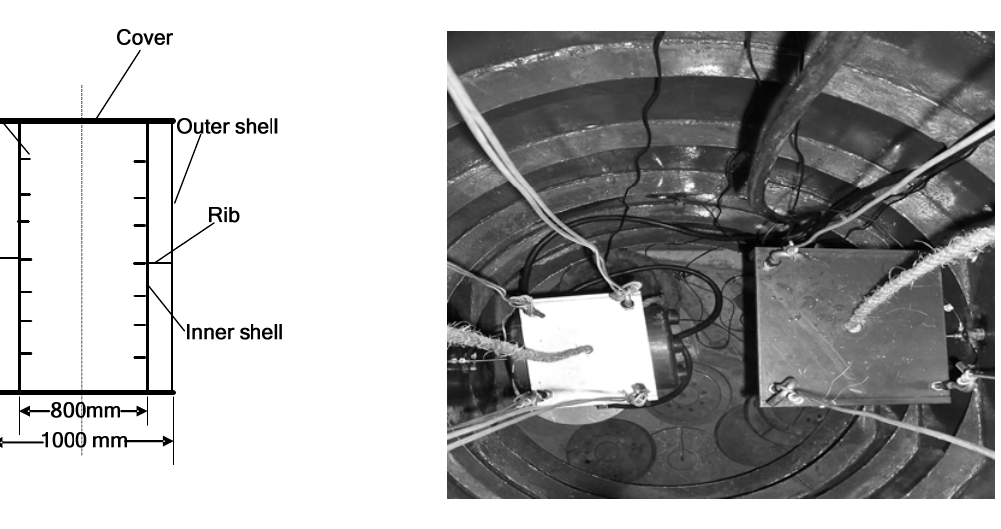
Figure 5. Structure of the ribbed double-shell model. Figure 6. Positions of two exciters.